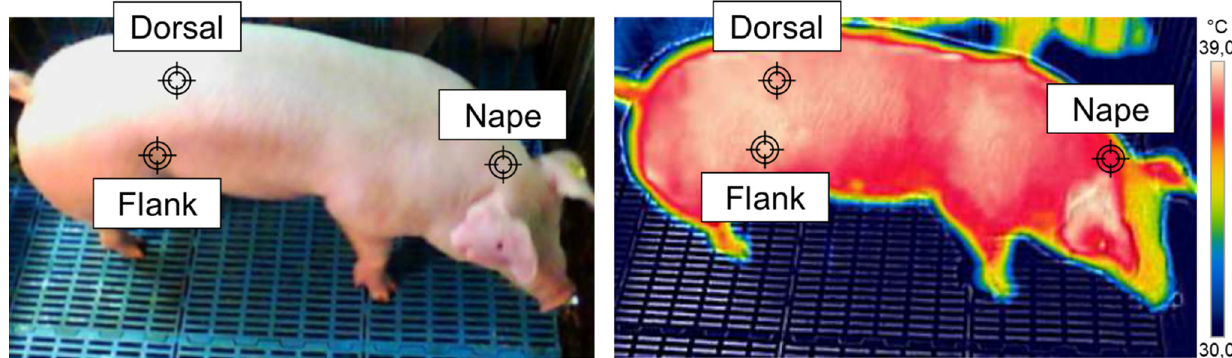
Figure 1. Graphical representation of nape, dorsal and flank skin temperatures measured through thermographic analysis in pigs reared under thermoneutral and high ambient